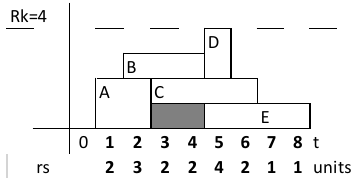
Fig. 6. Resource histogram (feasible project